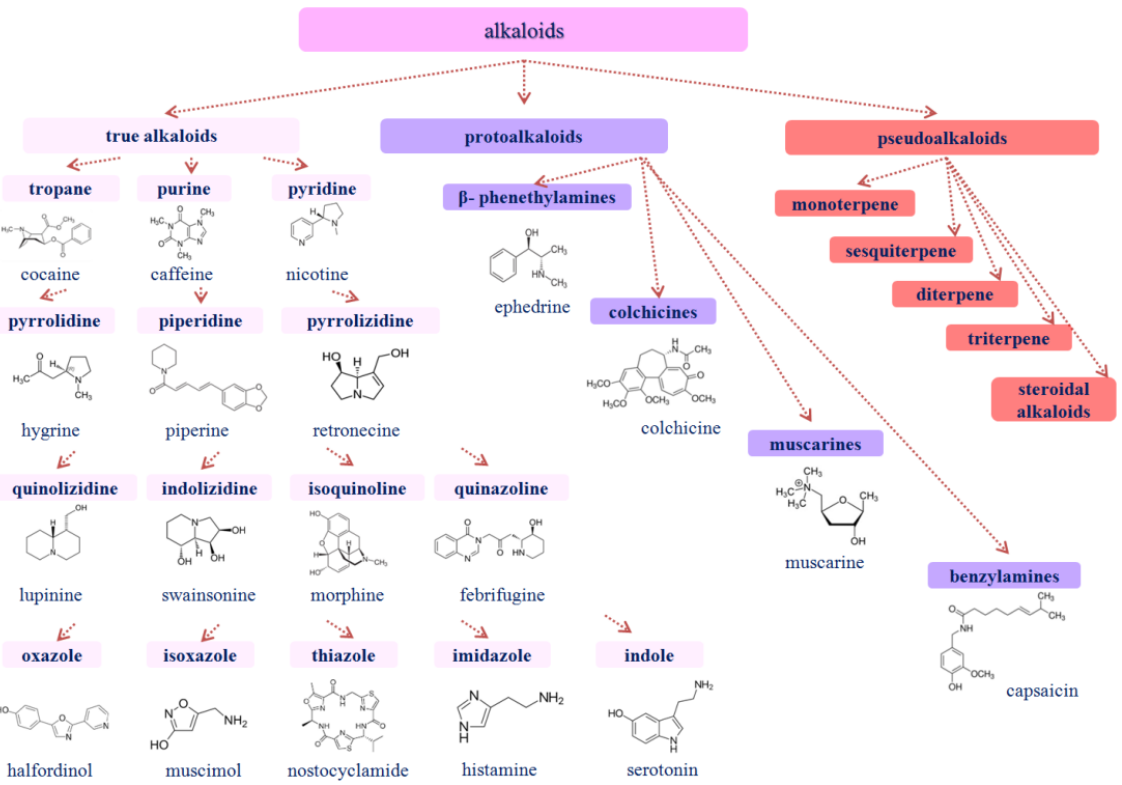
Figure 2. The classification of plant alkaloids and the chemical structures of some representatives.